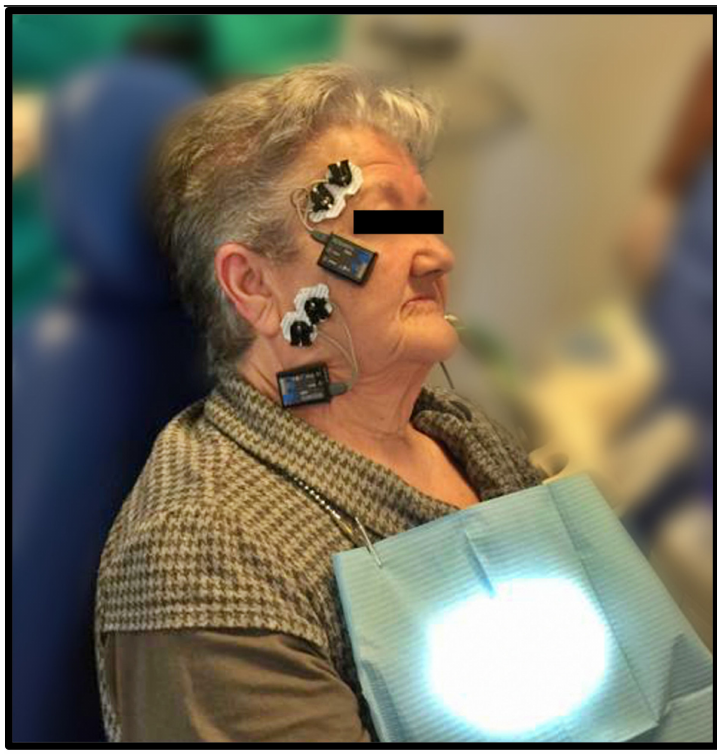
Figure 3. Pre-needling registry of the activity in MI